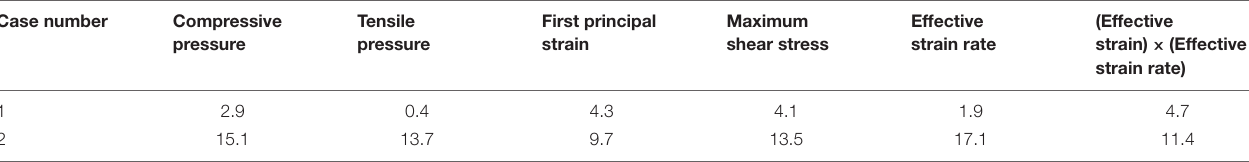
FIGURE 1 | Modalities [T1-magnetization-prepared rapid acquisition gradient echo (MPRAGE), T2-fluid attenuation inversion recovery (FLAIR), susceptibility-weighted imaging (SWI), and apparent diffusion coefficient (ADC)] from magnetic resonance imaging (MRI) images on two transverse planes, shown by yellow lines on sagittal plane section for cases 1 and 2 (second column from left). For each case, the top row shows the coup region images from blunt impact, and the bottom row shows the contrecoup region. Yellow arrows show the coup and contrecoup on modalities. C and CC stand for coup and contrecoup regions, respectively. TABLE 3 | The time to reach the maximum of different variables in the brain